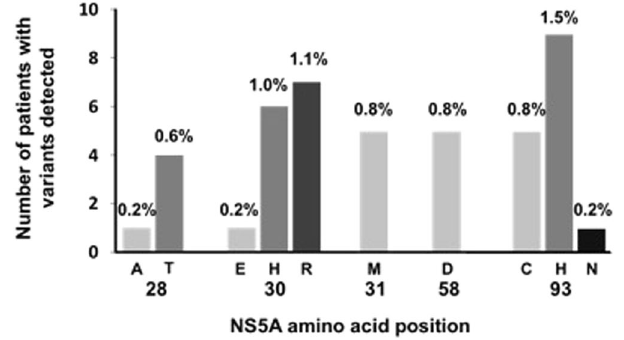
Figure 1. Types and prevalence of NS5A RASs to elbasvir detected in HCV GT1a-infected patients never treated with any NS5A inhibitor family in